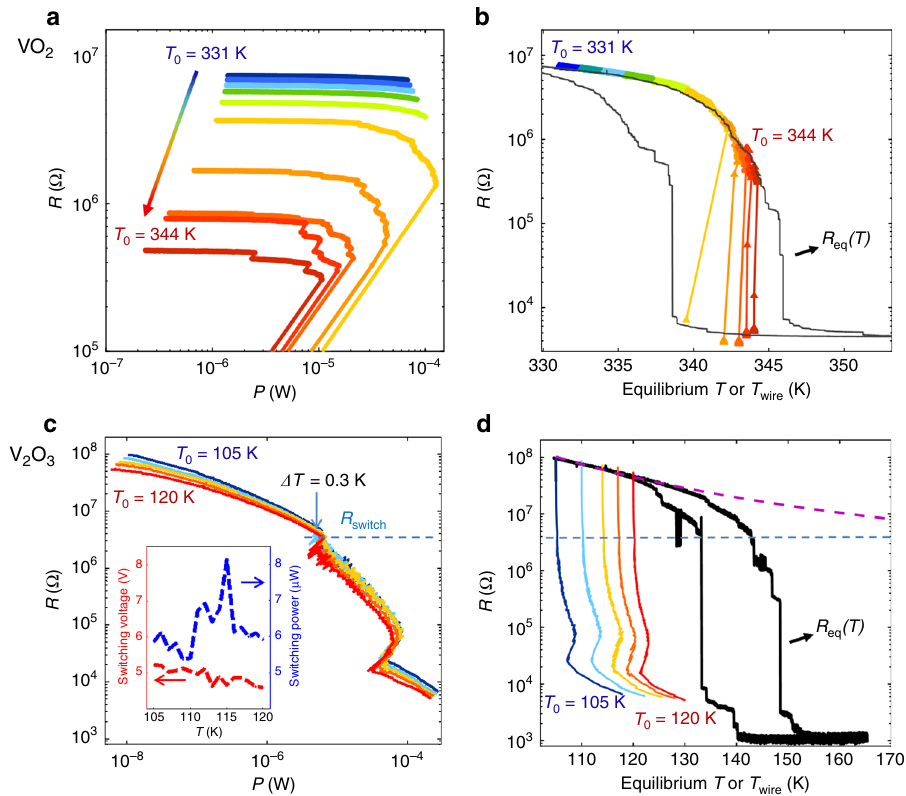
Fig. 2 Thermal vs. non-thermal IMT switching. a and c R ( P ) curves acquired at different substrate temperatures, T 0 , corresponding to the insulating state of VO 2 and V 2 O 3 nanowires, respectively. The IMT switching is manifested as abrupt resistance jumps. b and d R ( T wire ) curves derived from the corresponding R ( P ) curves and superimposed on the R eq ( T ) (black). For the VO 2 nanowire in b , the excellent correspondence between R ( T wire ) and R eq ( T ) signi fi es that the IMT is triggered thermally. For the V 2 O 3 nanowire in d , no such correspondence between R ( T wire ) and R eq ( T ) is observed, showing the inadequacy of a Joule-heating driven mechanism. The IMT switching in c begins with an increase of temperature Δ T = 0.3 K in T wire regardless of T 0 (light blue arrow), indicating a negligible role of Joule heating. The switching resistance R switch (dashed blue line) is lower than the fully insulating state resistance at any temperature. This is shown in d by the extrapolation of R eq ( T ) according to thermally activated resistance behavior with an activation energy of 60 meV (purple dashed line). The inset in c shows the switching voltage and power as functions of T 0